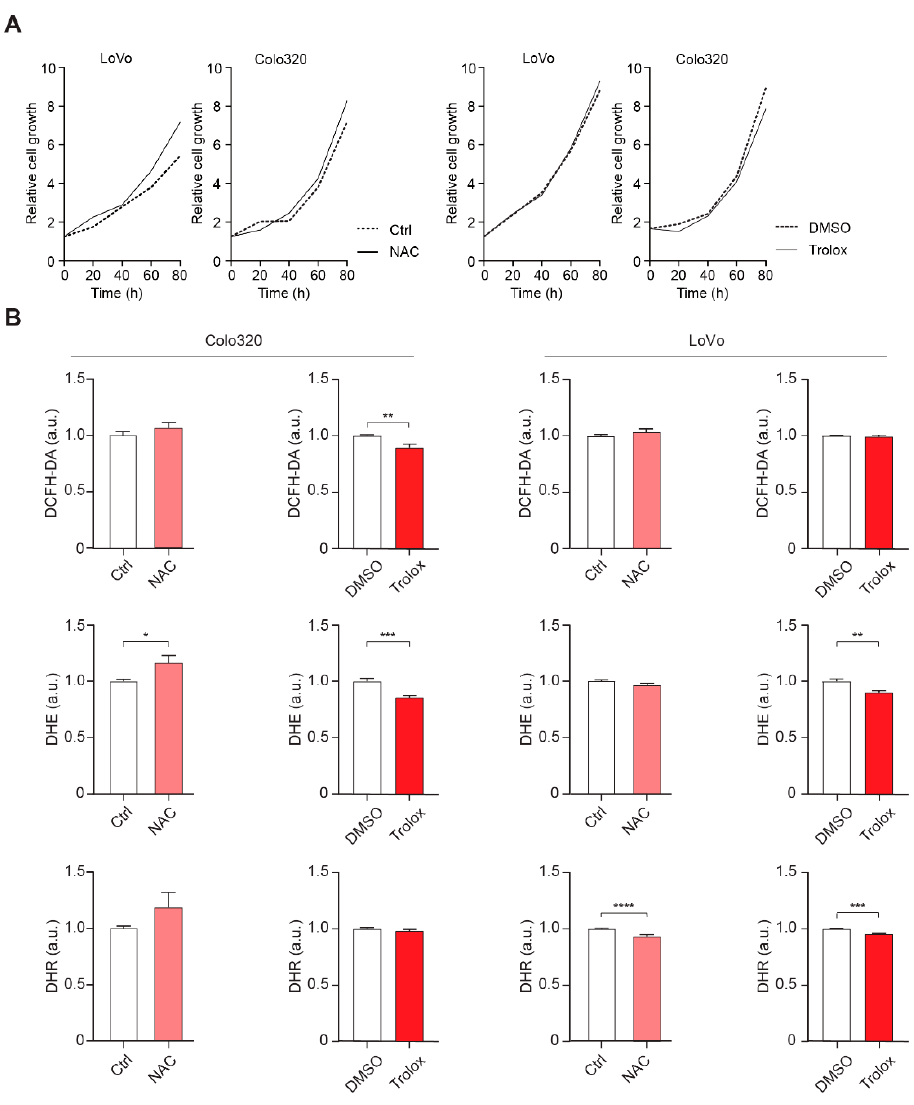
Figure 5. Effects of NAC or Trolox on proliferation of human colon cancer cell lines. ( A ) Real-time analyses of proliferation of two human colon cancer cell lines, LoVo and Colo320, cultured in medium supplemented with 200 µ M NAC or 20 µ M Trolox compared to untreated control (NAC) or DMSO control (Trolox); data are means of six replicates per cell line. ( B ) Graphs showing relative intensity of DCFH-DA, DHR, and DHE probes in LoVo and Colo320 cells, cultured as described above ( n = 6). DCFH-DA, dichloro-dihydro-fluorescein diacetate; DHR, dihydrorhodamine; DHE, dihydroethidium; a.u., arbitrary units; error bars indicate SEM; * p < 0.05, ** p < 0.01, *** p < 0.001, **** p <